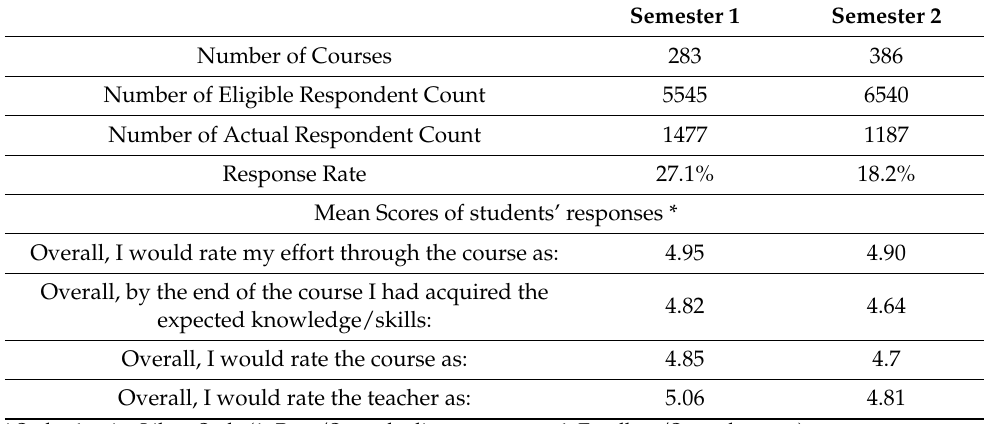
Table 2. Response rate and Mean Scores of students’ responses * of SFQ